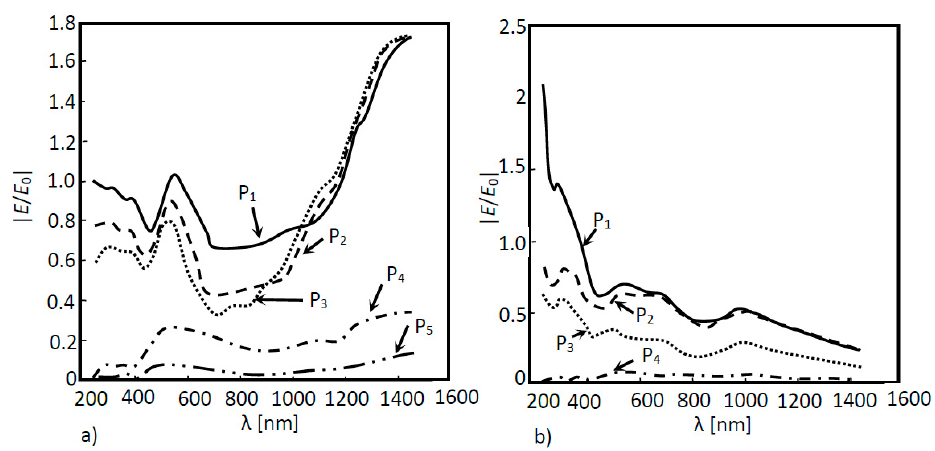
Figure 13. Normalized electric field as a function of the wavelength for a 3D CIGS structure. Measures were performed in four different positions: P 1 , P 2 , P 3, P 4 and P 5 for two different situations: ( a ) without a nanoantenna and ( b ) with a nanoantenna.